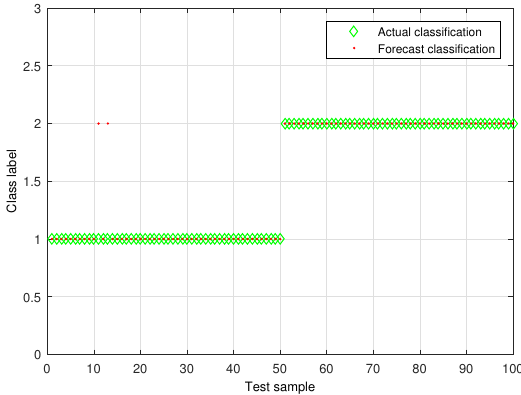
Figure 16. Pipeline leakage and non-leakage detection